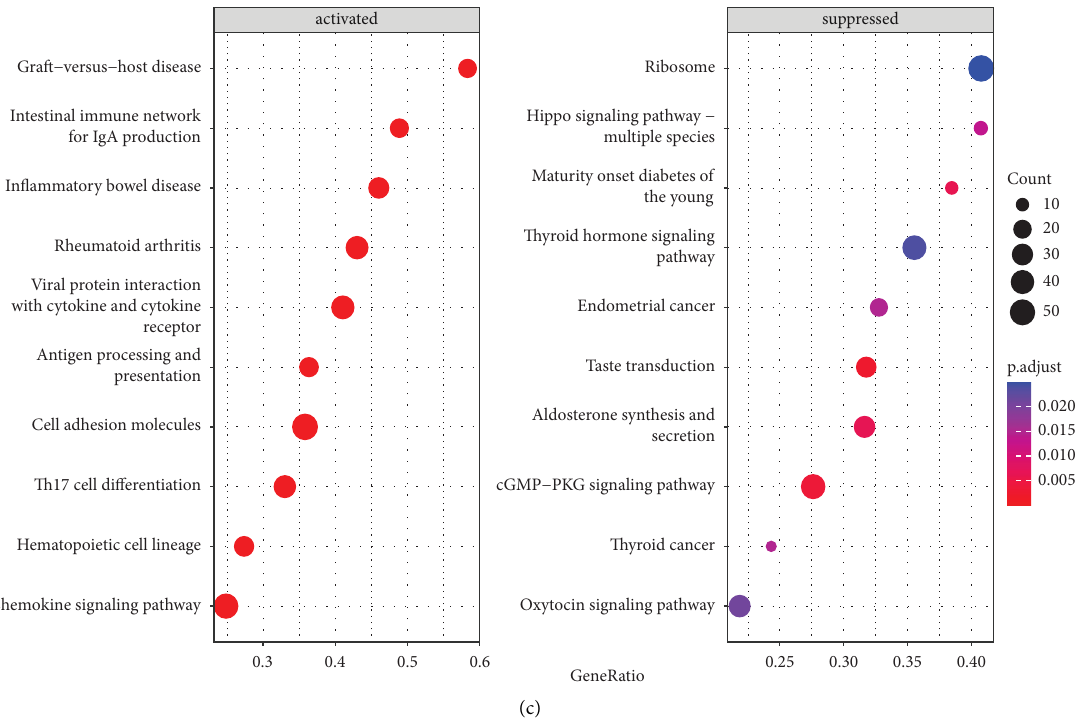
Figure 8: Gene set enrichment analysis (GSEA). (a) Te KEGG pathway in CXCL9 (highly expressed). (b) Te KEGG pathway in CXCR3 (highly expressed). (c) Te KEGG pathway in ITGAX (highly